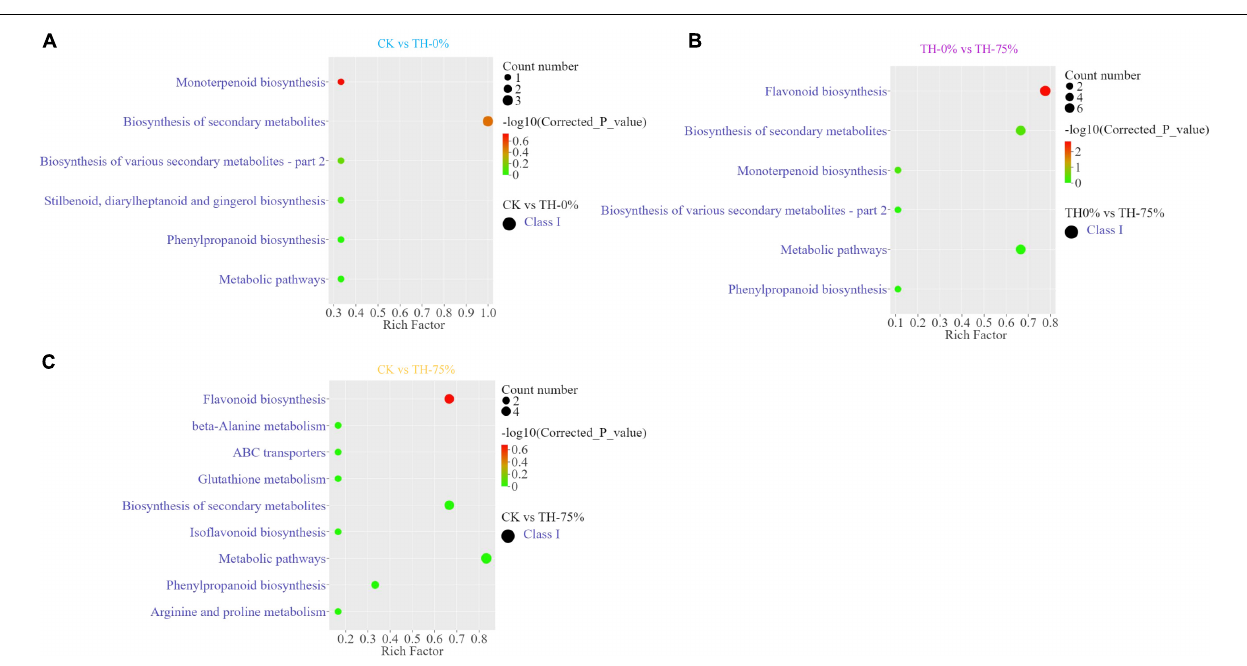
FIGURE 5 | Differentially accumulated metabolites (DAMs) and KEGG enrichment analysis in CK vs TH-0% (A) , TH-0% vs TH-75% (B) , and CK vs TH-75% (C)